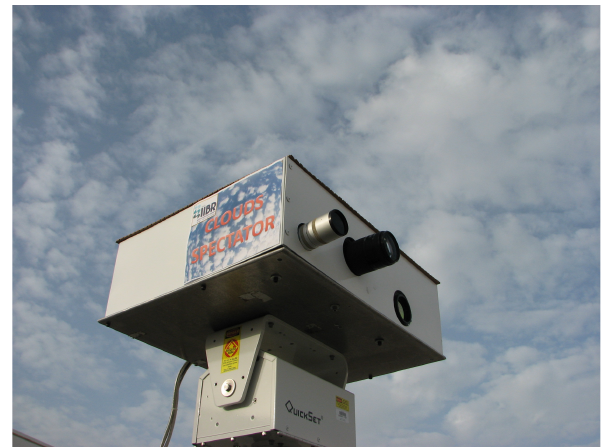
Fig. 1. CLOUDS SPECTATOR measurement assembly. It enables spatial, temporal, and multi spectral sky